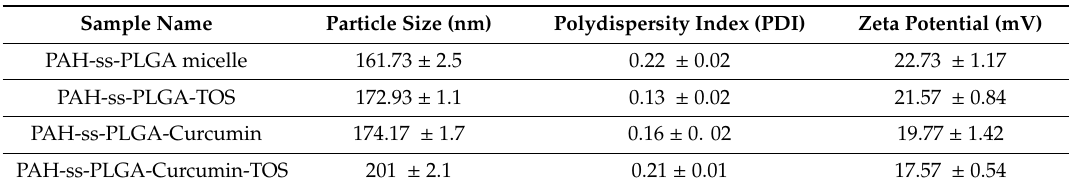
Table 1. The m ean particle size, polydispersity index (PI), and zeta potential of empty, TOS, and/or curcumin-loaded micelles in distilled water (dH 2 O) at 25 ℃ .